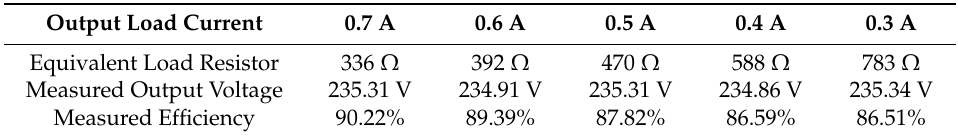
Figure 18. Photograph of supply of the experimental LED streetlight module using the presented driver at a utility-line voltage of 220 V, AC: Alternating-Current. Table 4. Measured output voltage and efficiency versus output load current under an input utility-line voltage of 220 V.